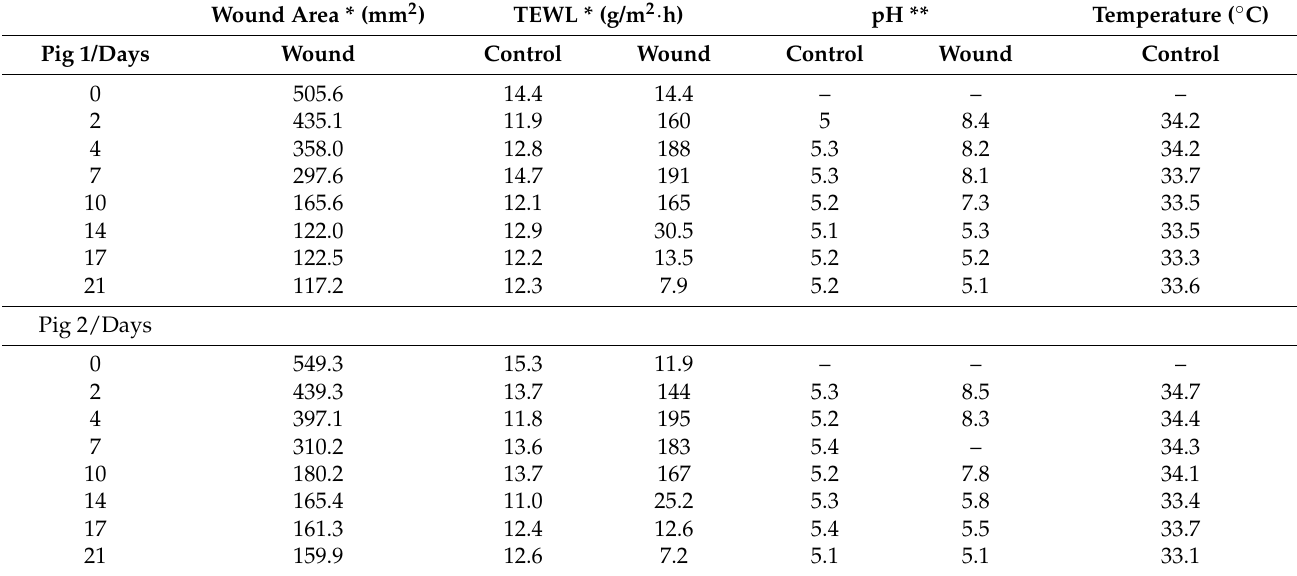
Table 1. Summary of calculated wound area, trans-epidermal water loss (TEWL), pH, and skin surface temperature measurements performed during the in vivo wound healing. The measurements were recorded at the time points when the dressings were changed during the healing cycle. * For wound area calculations and TEWL measurements, the values corresponding to wound position 1 are provided. ** For pH, the readings provided correspond to wound position 1 for pig 1 and position 5 for pig 2. The skin surface temperature values presented here originate from control measurements on the left side of the pigs’ backs. The “–” sign indicates that no measurement was performed at that particular